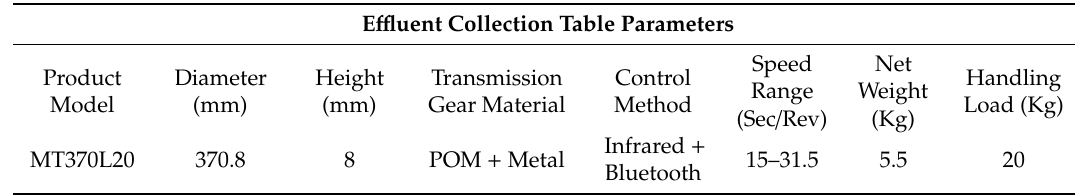
Figure 4. Effluent collection table with beakers arranged on the top capable of rotating Figure 4. E ffl uent collection table with beakers arranged on the top capable of rotating automatically in automatically in timed increments. timed increments. Table 1. The parameters for the e ffl uent collection table. E ffl uent Collection Table